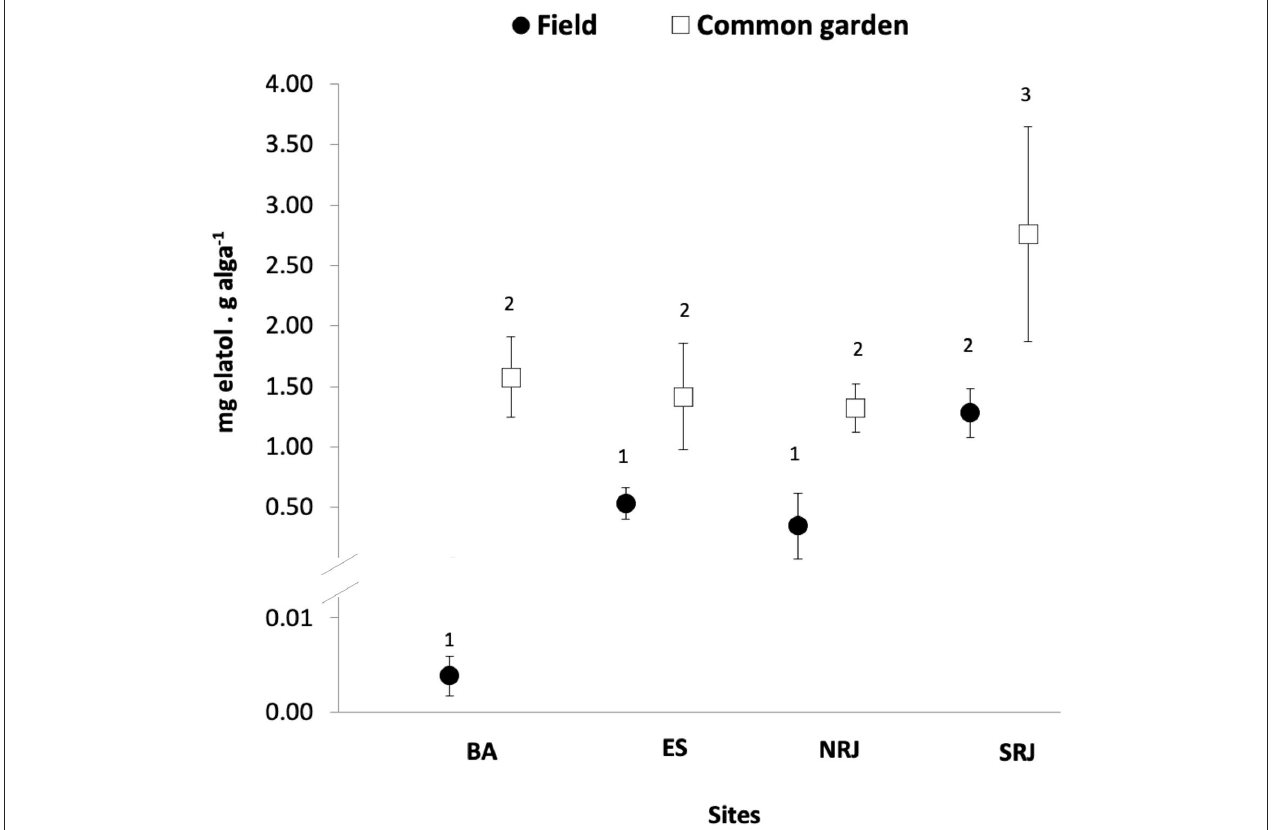
FIGURE 1 | Elatol levels between Laurencia dendroidea populations were maintained under common garden conditions. Values are similar except for the SRJ population and are higher than field-collected specimens. Values are mean ± SD. BA, Bahia; ES, Espírito Santo; NRJ, Northern Rio de Janeiro; SRJ, Southern Rio de Janeiro. Experimental conditions with the same numbers are not significantly different ( p < 0.05, ANOVA/SKN test, n = 4).